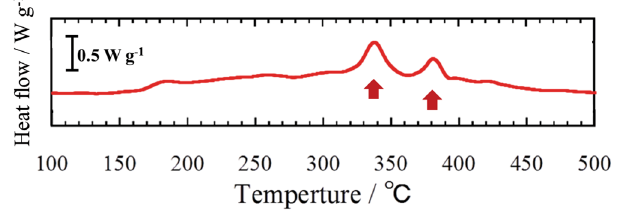
Figure 2. The DSC curve for the NMC–LPS composites after the initial charge.